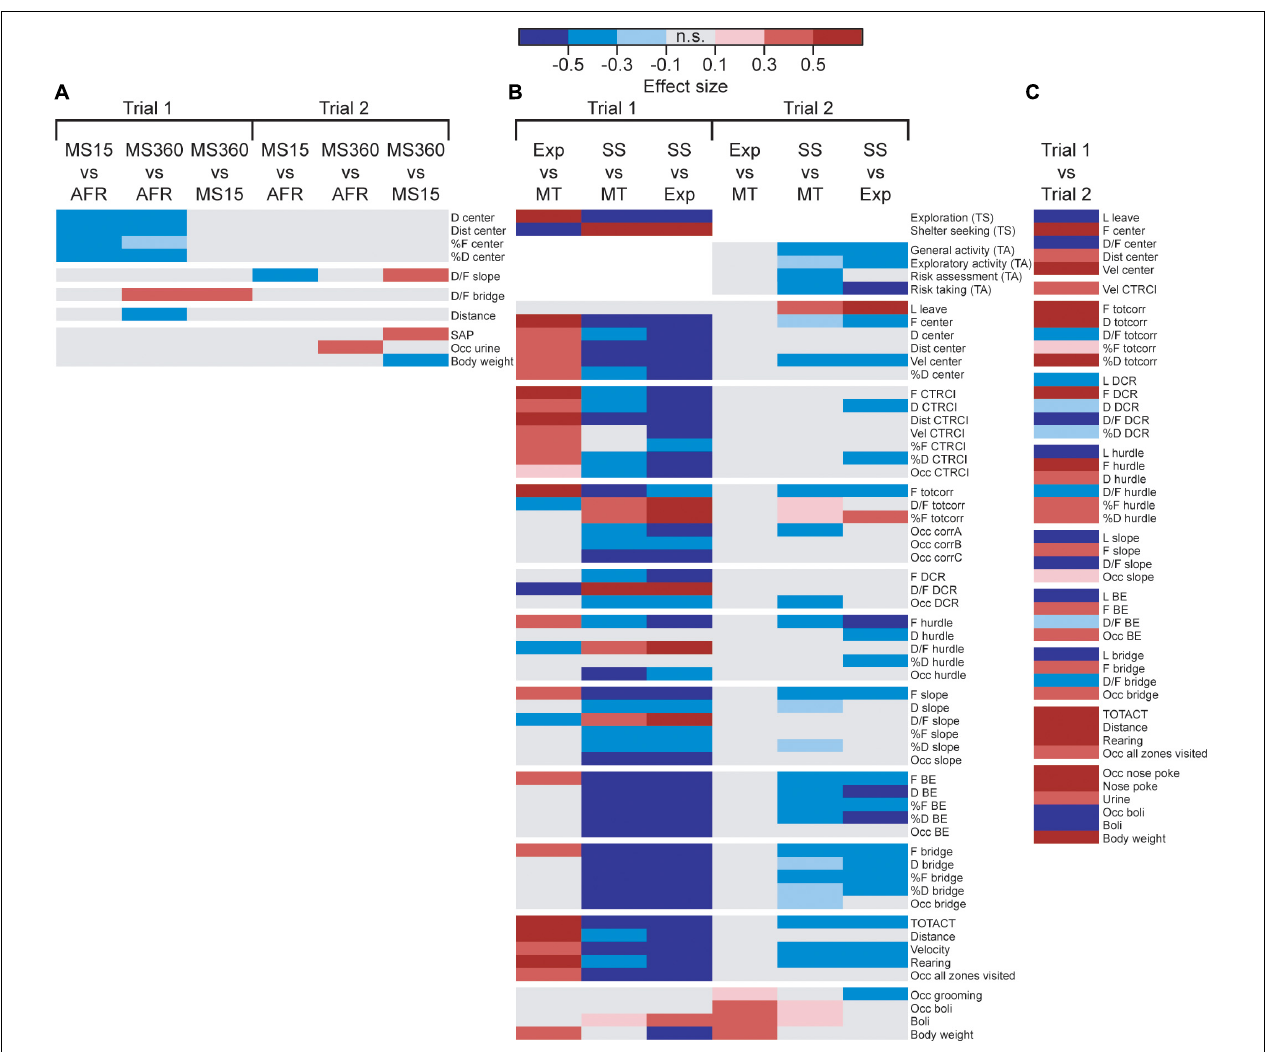
FIGURE 2 | Heatmap of effect sizes for the significant differences comparing the (A) rearing conditions in trials 1 and 2 (MS15, n trials1 , 2 = 21; MS360, n trial1 = 30, n trial2 = 28; AFR, n trial1 = 20, n = trial2 = 19), (B) behavioral types in trials 1 and 2 (Explorers, n trial1 = 9, n trial2 = 8; Shelter seekers, n trial1 , 2 = 20; Main type n trial1 = 42, n trial2 = 39), and ( C ) trial 1 ( n = 71) with trial 2 ( n = 68) in the whole cohort. The parameters are sorted as followed: rank order procedures (type scores and trend analysis categories), zone measures (center, CTRCI, totcorr, DCR, hurdle, slope, BE, and bridge), activity parameters, and miscellaneous parameters. Parameters without any significant difference are not shown in the figure. AFR, animal facility reared; BE, bridge entrance; CTRCI, central circle; corr, corridor; D, duration; DCR, dark corner room; D/F, duration per visit; Dist, total distance; F frequency; MS15, maternal separation 15 min; MS360, maternal separation 360 min;